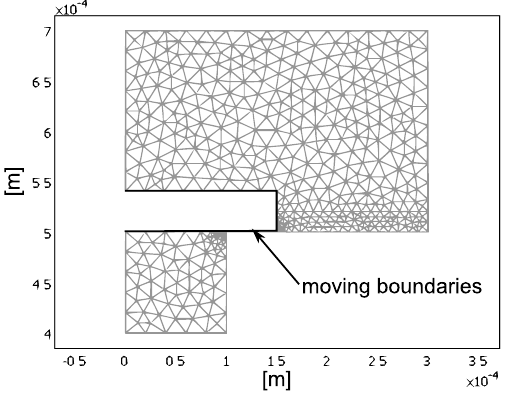
Fig. 6: The mesh of the fluid section of the valve.